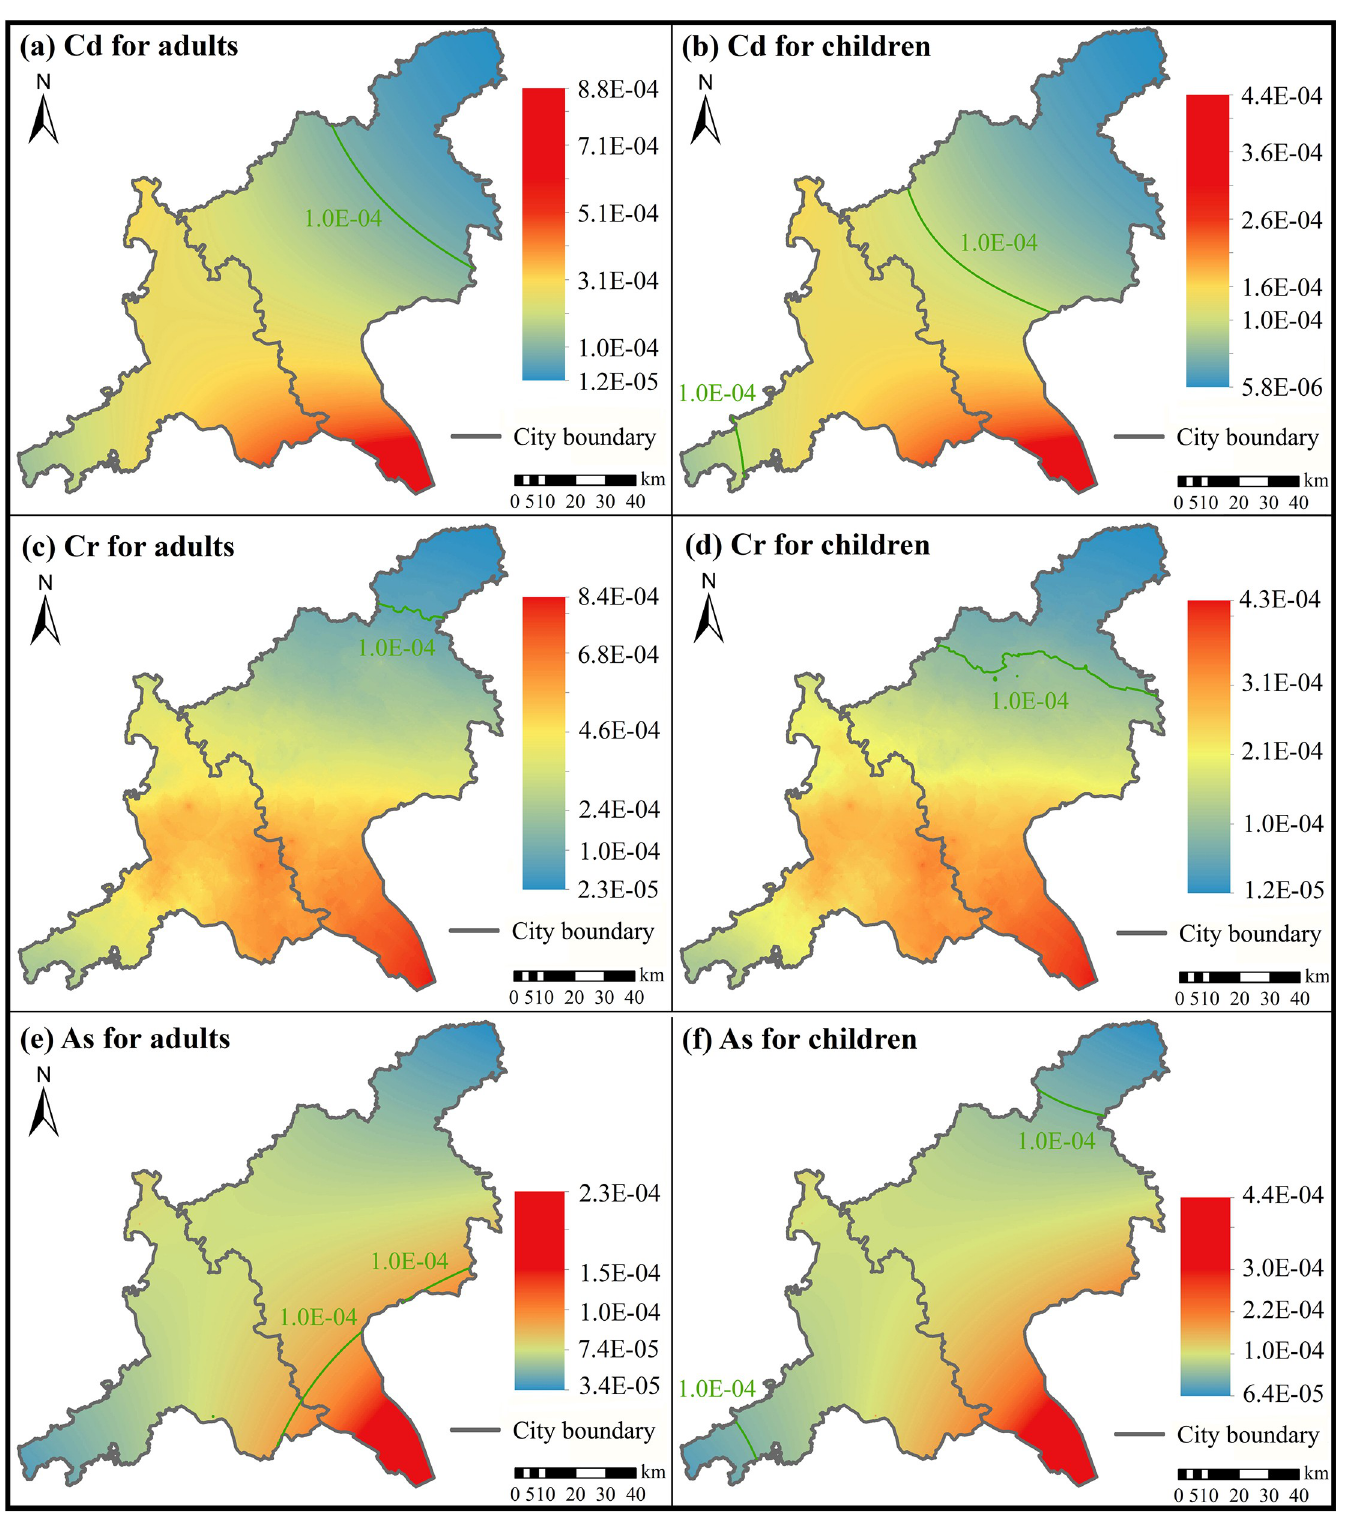
Fig 7. Spatial distribution of CR values. Cd for (a) adults and (b) children, Cr for (c) adults and (d) children, and As for (e) adults and (f) children.